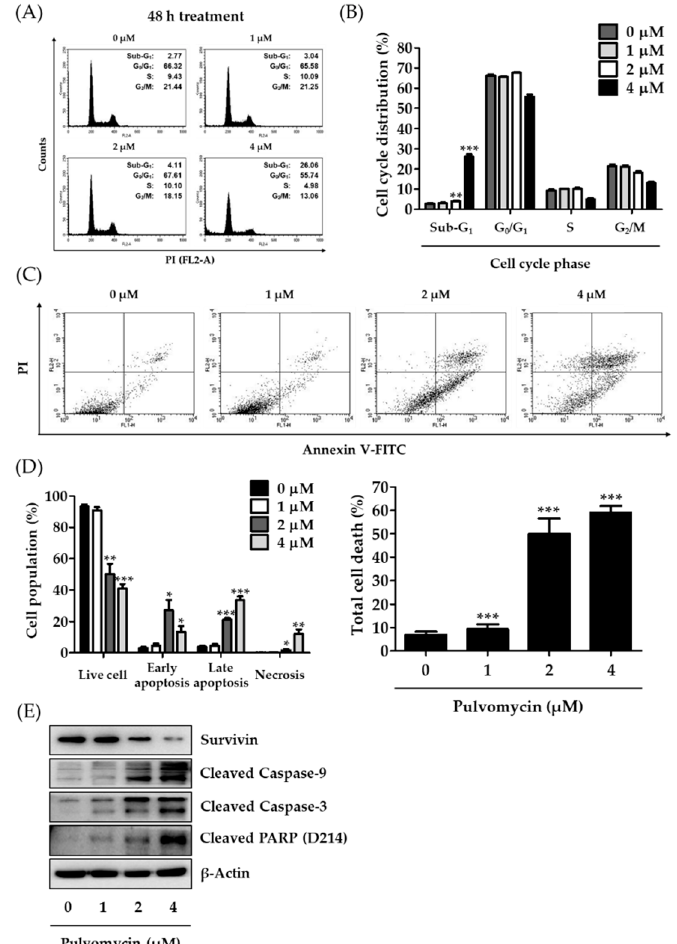
Figure 4. Effects of pulvomycin on apoptotic cell death. ( A , B ) MDA-MB-231-DTR cells were treated with the indicated concentrations of pulvomycin for 48 h and fixed with 70% ethanol for 24 h. After incubation with RNase A and PI for 30 min, cell cycle distribution was determined using flow cytometry. Data are presented as the mean ± SD ( n = 3). ** p < 0.01 and *** p < 0.001 compared with the control. ( C , D ) MDA-MB-231-DTR cells were treated with the indicated concentrations of pulvomycin for 48 h and stained with Annexin V-fluorescein isothiocyanate (V-FITC) and PI. Annexin V/PI-positive cells were analyzed using flow cytometry to evaluate the apoptotic cell population. Data are presented as the mean ± SD ( n = 3). * p < 0.05, ** p < 0.01, and *** p < 0.001 compared with the control. ( E ) MDA-MB-231-DTR cells were treated with the indicated concentrations of pulvomycin for 48 h, and levels of survivin, cleaved caspase-9, cleaved caspase-3, and cleaved poly